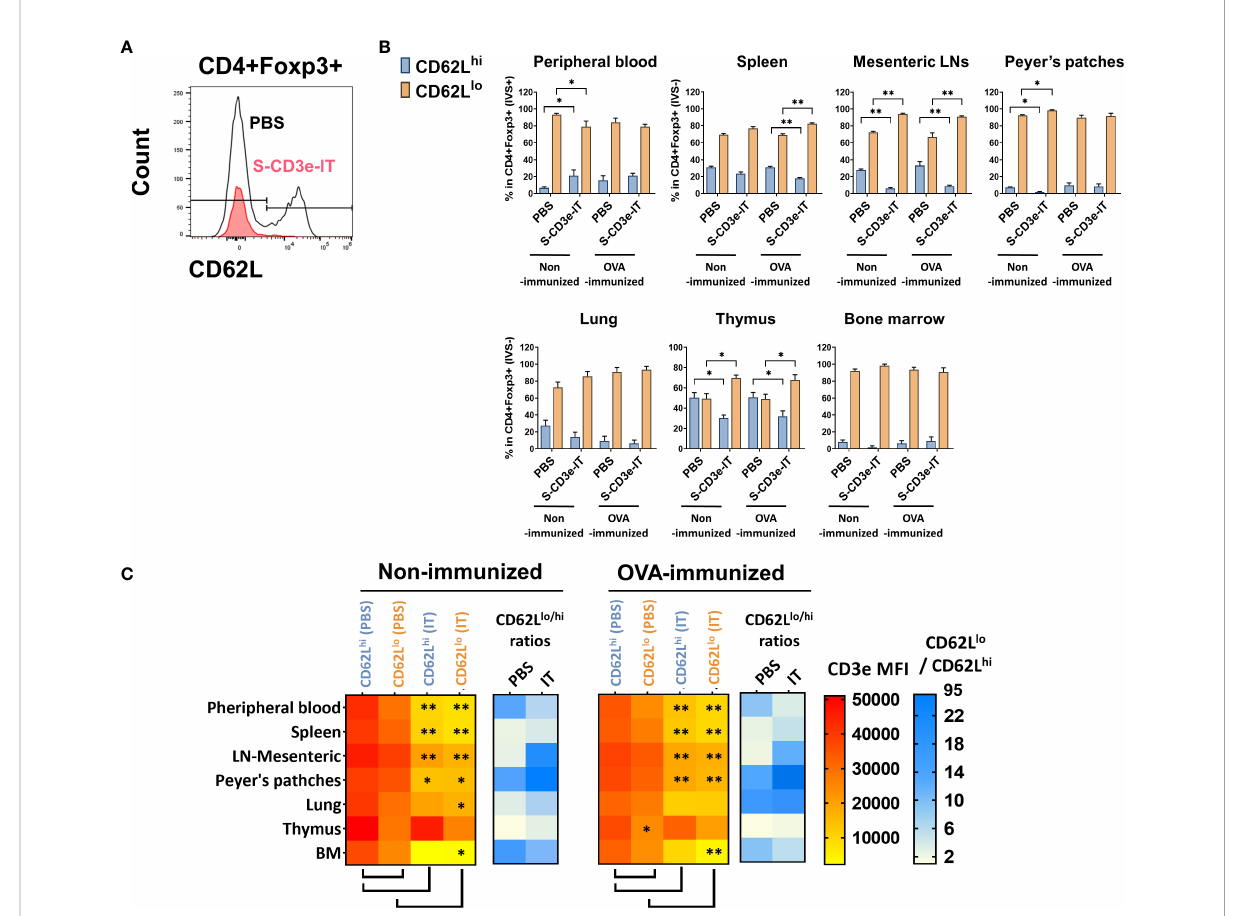
FIGURE 3 CD3 dim CD62L lo Treg enrichment correlates with CD3e expression. (A) The fl ow cytometry gating strategy for CD4+Foxp3+CD62L lo and CD4 +Foxp3+CD62L hi . (B) CD62L lo and CD62L hi (% in CD4+Foxp3+ cells) are shown for the peripheral blood (IVS+) and tissue-resident (IVS-) portions of spleen, mesenteric LNs, peyer ’ s patches, lungs, thymus, and bone marrow. (C) The heatmap of CD3e MFI (yellow to red) on CD4 +Foxp3+CD62L lo and CD4+Foxp3+CD62L hi cells in tested organs. CD3e MFI on CD62L lo was higher than CD62L hi in all tested organs. A statistical comparison of CD3e MFI of two groups, CD62L lo (PBS) vs. CD62L hi (PBS) and PBS-treated vs. S-CD3e-IT-treated mice, is denoted with an asterisk (*) on the heat map. The heatmap of the CD62L lo -to-CD62L hi ratios (white to blue). The ratio increased after S-CD3e-IT treatment except in peripheral blood and bone marrow. Nonimmunized mice were treated with PBS ( n = 4~5, depending on organs) or S- CD3e-IT ( n = 4~6). OVA-immunized mice were treated with PBS ( n = 3~4) or S-CD3e-IT ( n = 7~8). (* p < 0.05 and ** p <